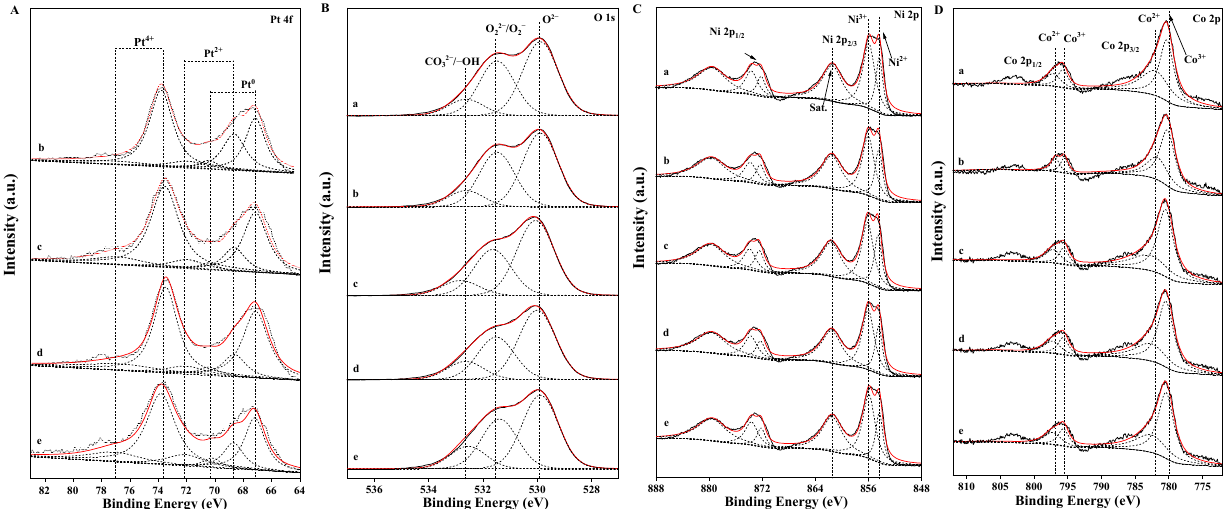
Figure 7. XPS spectra of Pt 4f ( A ), O 1s ( B ), Ni 2p ( C ), and Co 2p ( D ) regions over Pt n /Ni 1.5 Co 0.5 AlO catalysts: (a) Ni 1.5 Co 0.5 AlO; (b) Pt 1 /Ni 1.5 Co 0.5 AlO; (c) Pt 2 /Ni 1.5 Co 0.5 AlO; (d) Pt 4 /Ni 1.5 Co 0.5 AlO; (e) Pt 6 /Ni 1.5 Co 0.5 AlO.